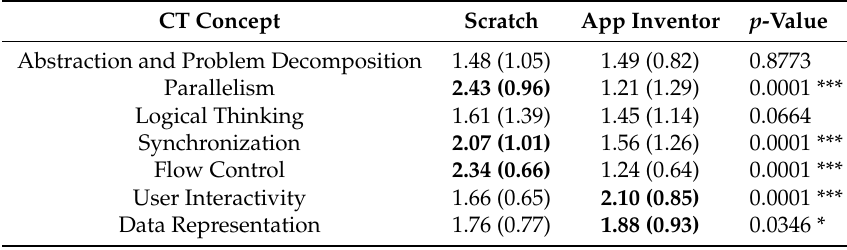
Table 3. The overall comparison result of Scratch and App Inventor in terms of computational thinking concepts according to t -test. The numbers outside of the parentheses are the averages of the effectiveness scores calculated by the proposed rubric, while the values inside the parentheses are the standard deviations of the